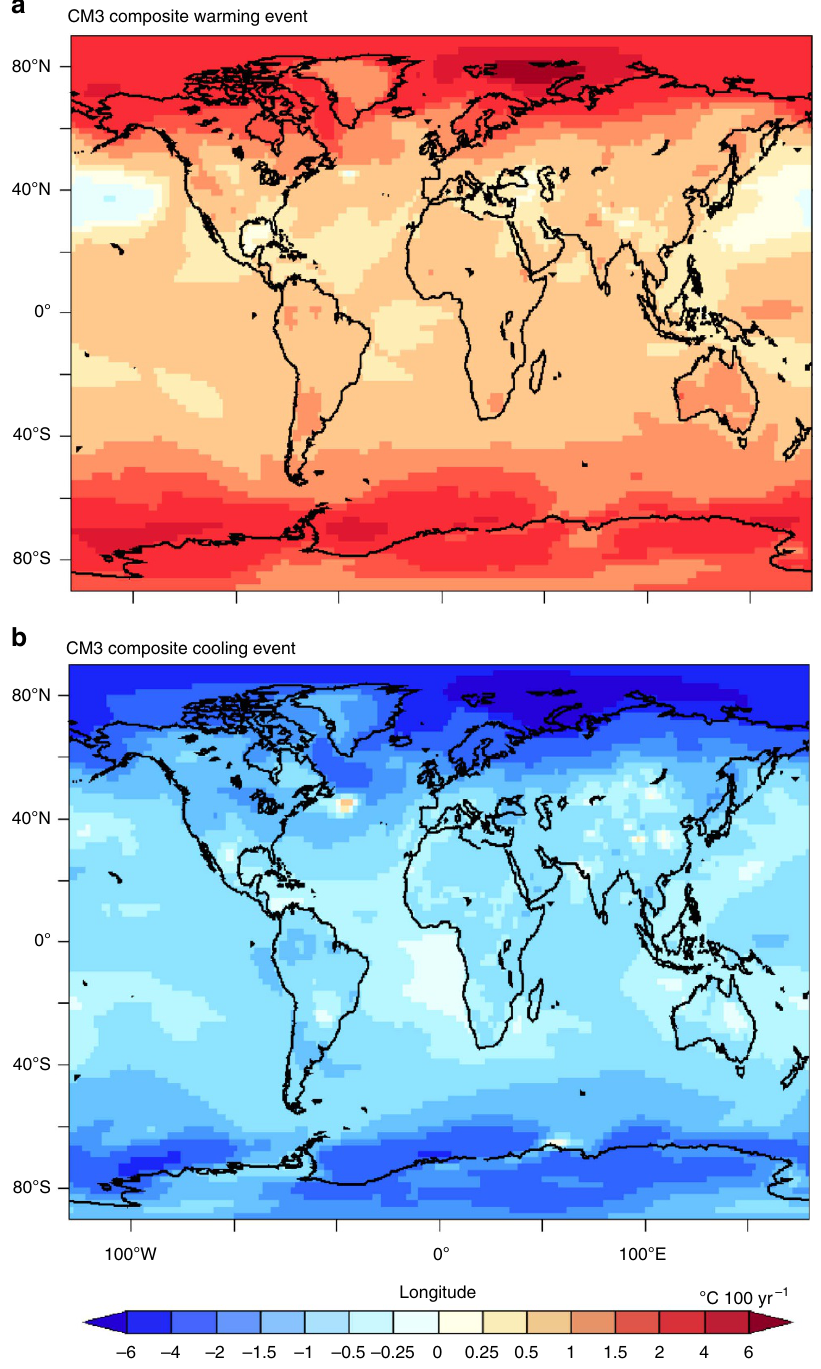
Figure 4 | Composite trend maps of multidecadal internally generated global warming and cooling events from the CM3 control run. The composites are based on average of: ( a ) 25 individual warming events shown in Supplementary Fig. 3; ( b ) 25 individual cooling events shown in Supplementary Fig. 4. Unit: (cid:2) C 100 yr (cid:2) 1